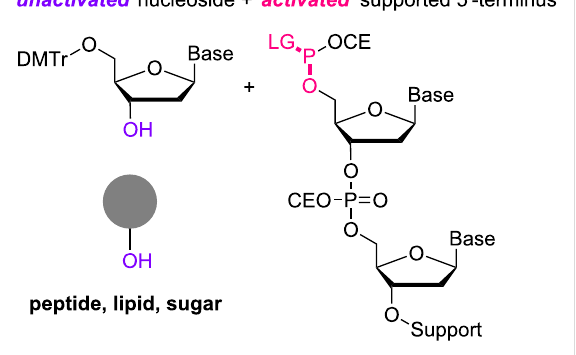
Figure 1: Schematic illustration of possible support-assisted